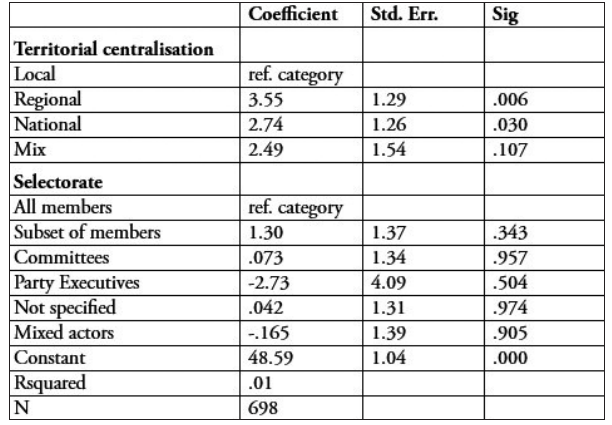
Table 8: The multiple regression model measuring the influence